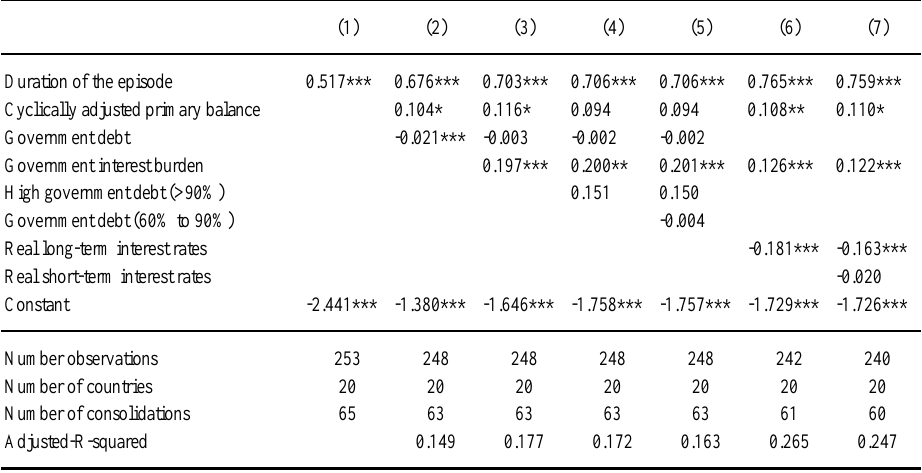
Table 4: Determinants of duration of consolidations – the role of initial conditions (estimates of hazard function using Weibull model, coefficients shown as hazard